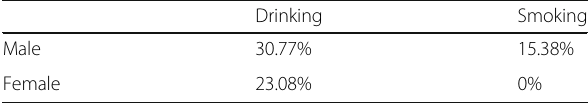
Table 6 Subject ratings of each gender group with respect to drinking, smoking during the study